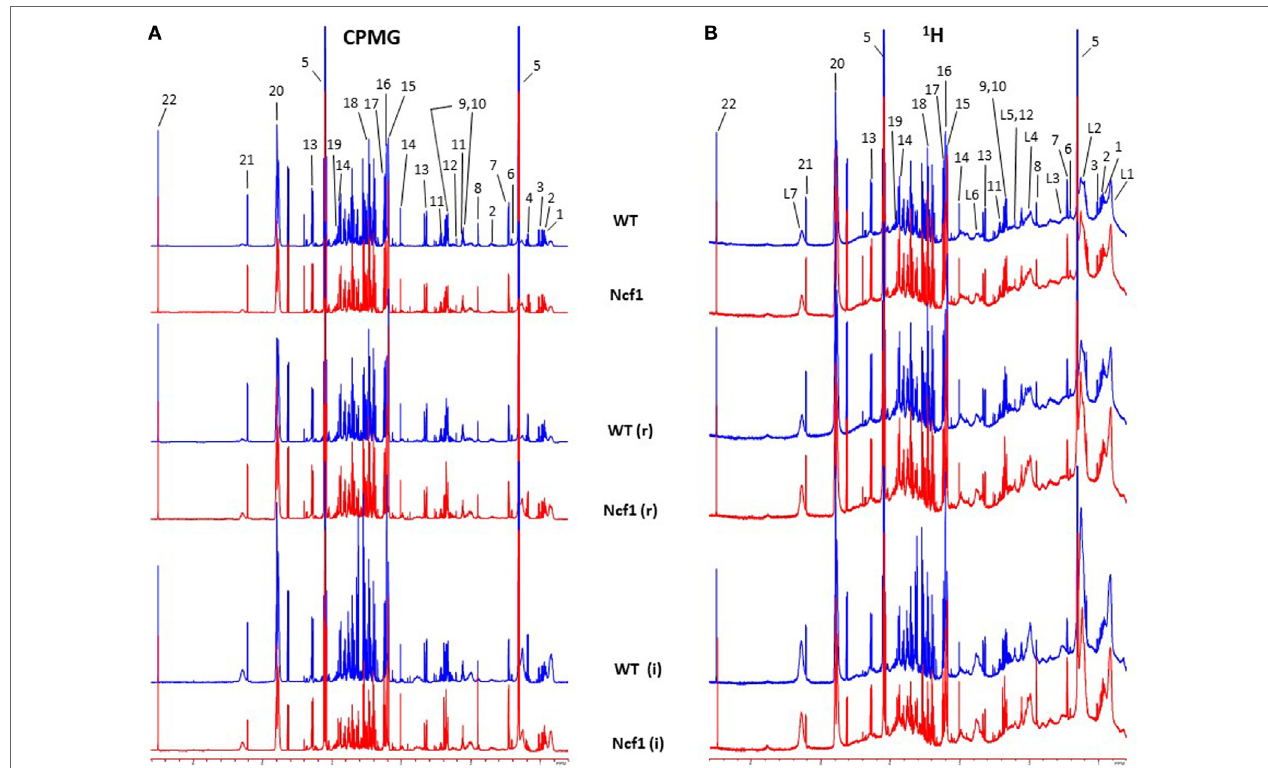
FigUre 5 | Representative Carr–Purcell–Meiboom–Gill (CPMG) (a) and 1 H (B) nuclear magnetic resonance spectra of blood sera from wild-type (WT) and Ncf1-mutant (Ncf1) mice at baseline, after recovery of the first period of dextran sulfate sodium (DSS)-induced colitis (r) and after the second period of DSS-induced colitis (i). The CPMG pulse sequence suppresses the broad signals from macromolecules allowing a better characterization of the signals arising from the small metabolites. Signal assignments: (1) isoleucine, (2) leucine, (3) valine, (4) β -hydroxybutyrate, (5) lactate, (6) threonine, (7) alanine, (8) acetate, (9) proline, (10) glutamate, (11) glutamine, (12) methionine, (13) malate, (14) creatine, (15) choline, (16) phosphorylcholine/glycerophosphocholine, (17) taurine, (18) glycine, (19) serine, (20) water, (21) α -glucose, (22) fumarate, (L1) lipid methyls, (L2) lipid aliphatic chain, (L3) lipid β -methylenes, (L4) lipid allylic methylenes, (L5) lipid α - methylenes, (L6) lipid polyunsaturated allylic methylenes, and (L7) lipid